Question: Write the caption for this figure.
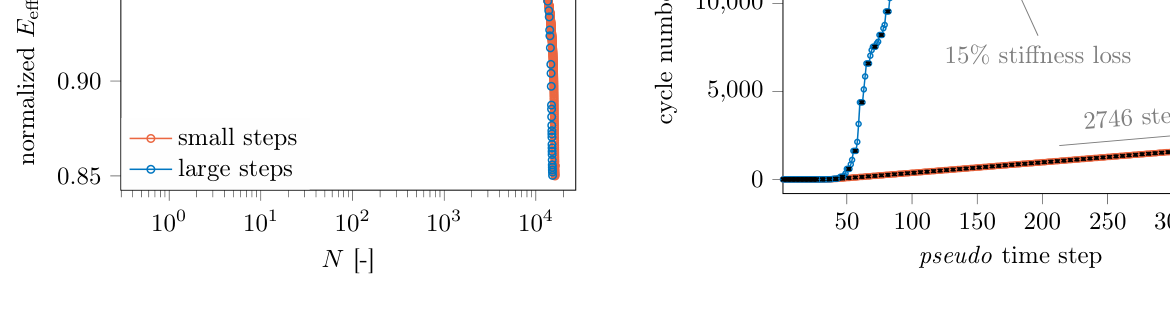
Answer: Stiffness reduction with number of cycles